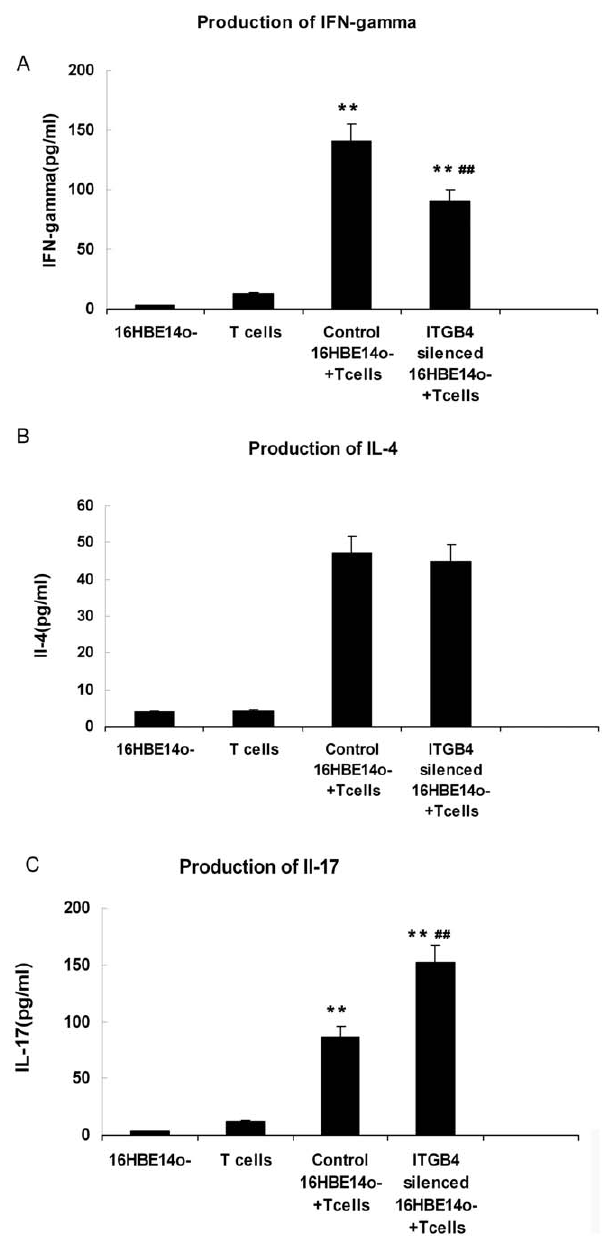
Figure 5. Cytokine concentrations in supernatants of the 16HBE14o- cells and T cells cocultures were quantified by ELISA. The graphs show mean ( 6 SEM) values from a representative experiment of six independent experiments. The content of (A) IFN- gamma, (B) IL-4 and (C) IL-17 was performed respectively.